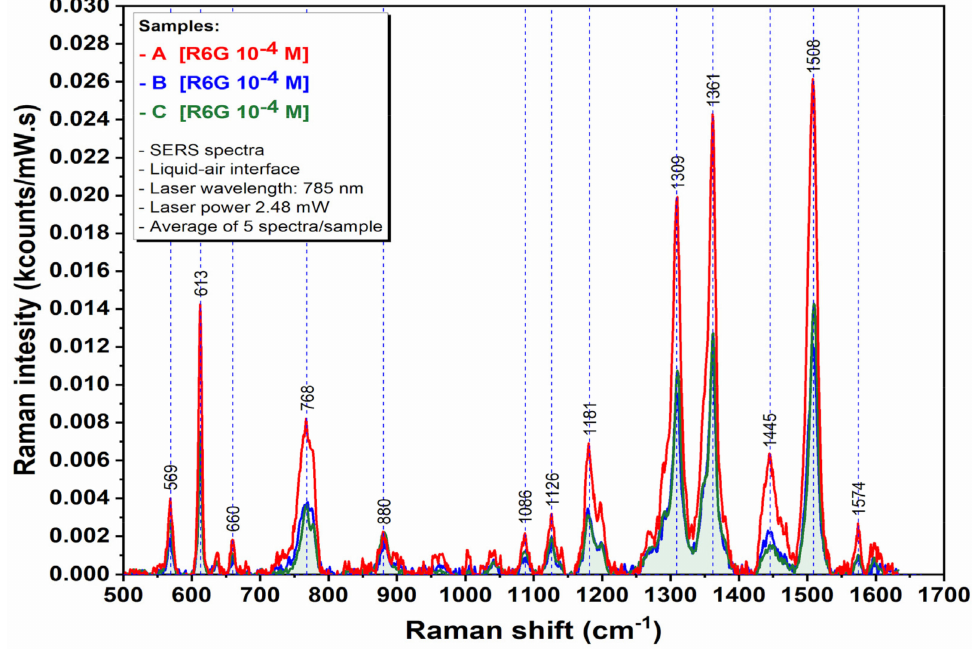
Figure 9. SERS spectra of R6G trapped at liquid-air interface in GNBs (samples A and B) and GNRs (sample C)